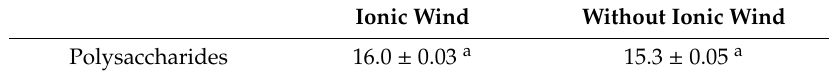
Table 1. Polysaccharide content under ionic wind and without ionic wind (g / 100 g).